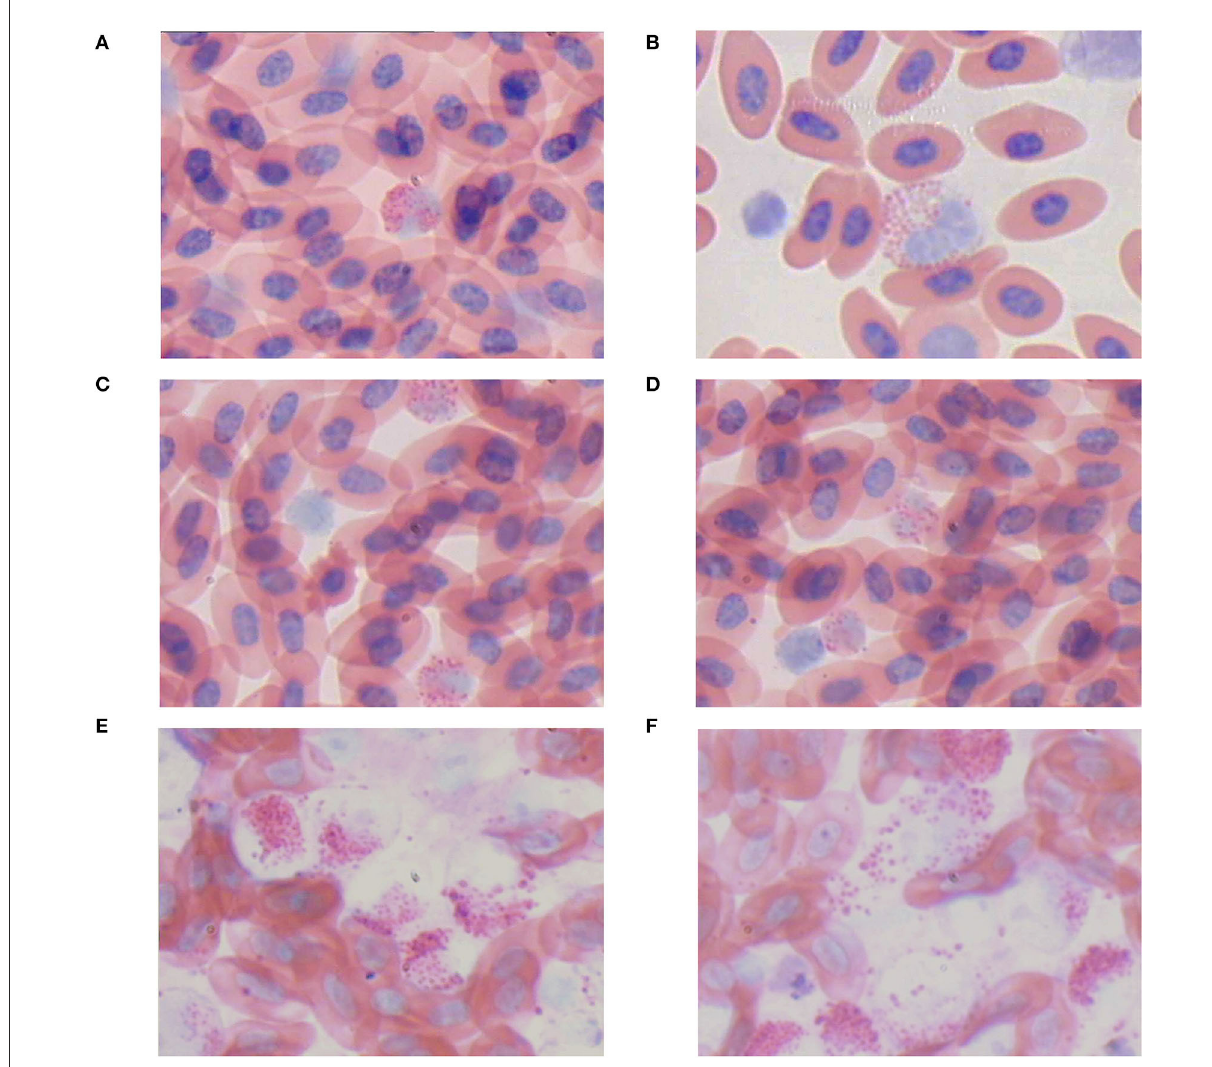
FIGURE10 Blood swears (ME, 400 × ). (A,B) An myelocyte-like tumor cell. (C,D) The number of myelocyte-like tumor cell was increased. (E,F) The lysis of myelocyte-like tumor